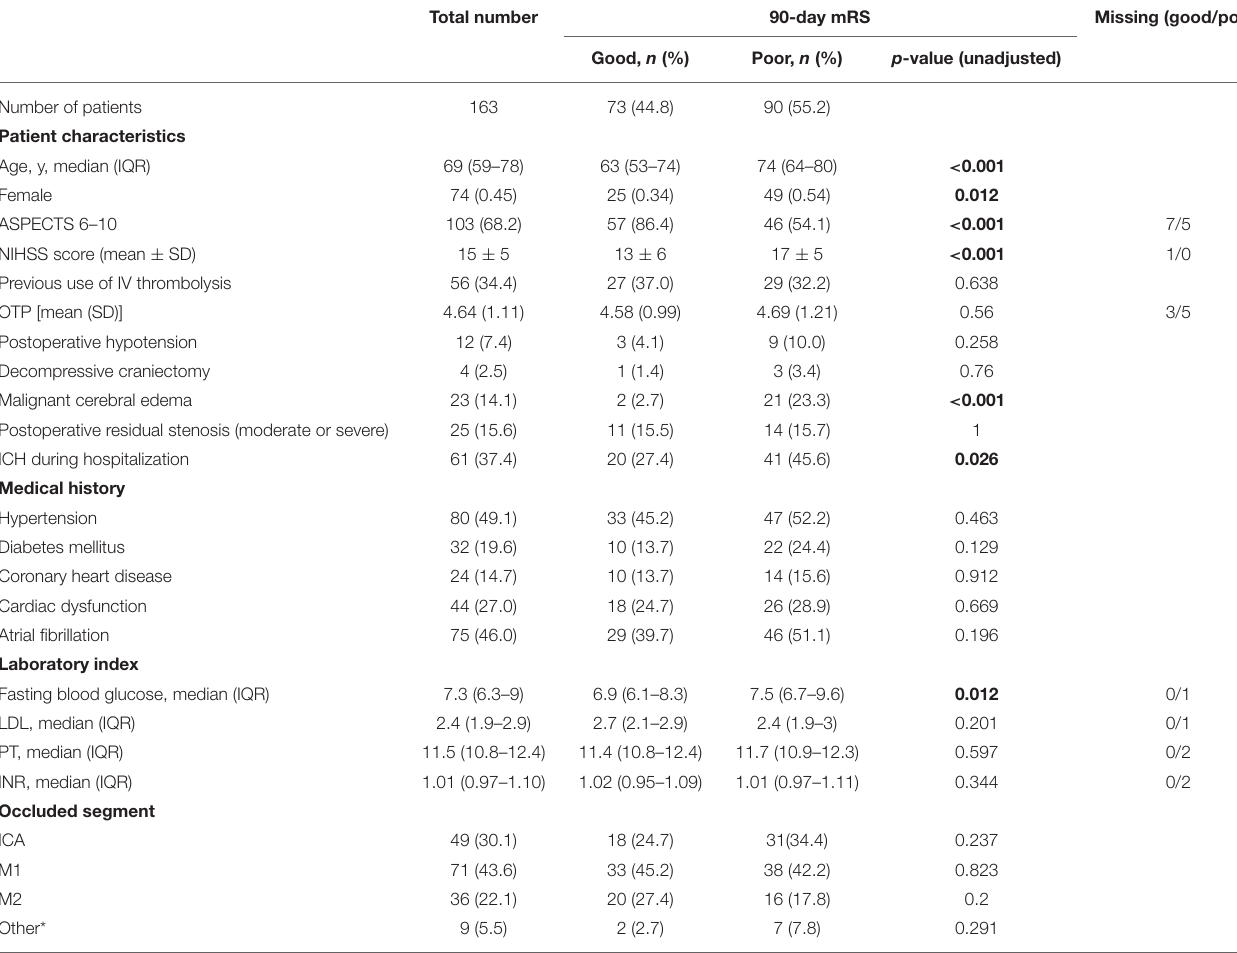
TABLE 1 | Baseline characteristics of study population compared between patients with good and poor functional outcome (mRS 0–2 vs.